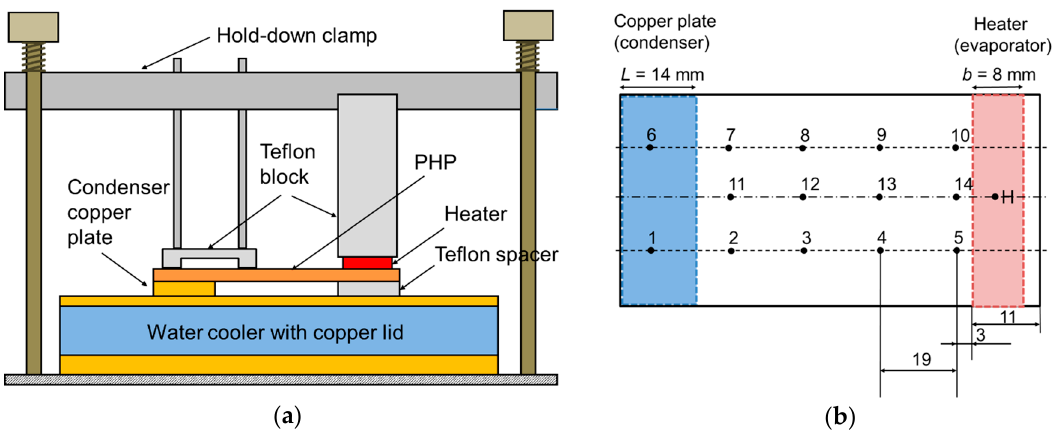
Figure 2. Measurement setup used for the characterization of the PHP with water cooling at the condenser zone. ( a ) Test bench, ( b ) positions of thermocouples and of copper plate (condenser zone) and heater (evaporator zone). Thermocouples 1–5 and 6–10 are arranged in one line on the top side of the PHP and 11–14 are arranged on one line at the bottom side. H represents the thermocouple directly inserted into the heater.